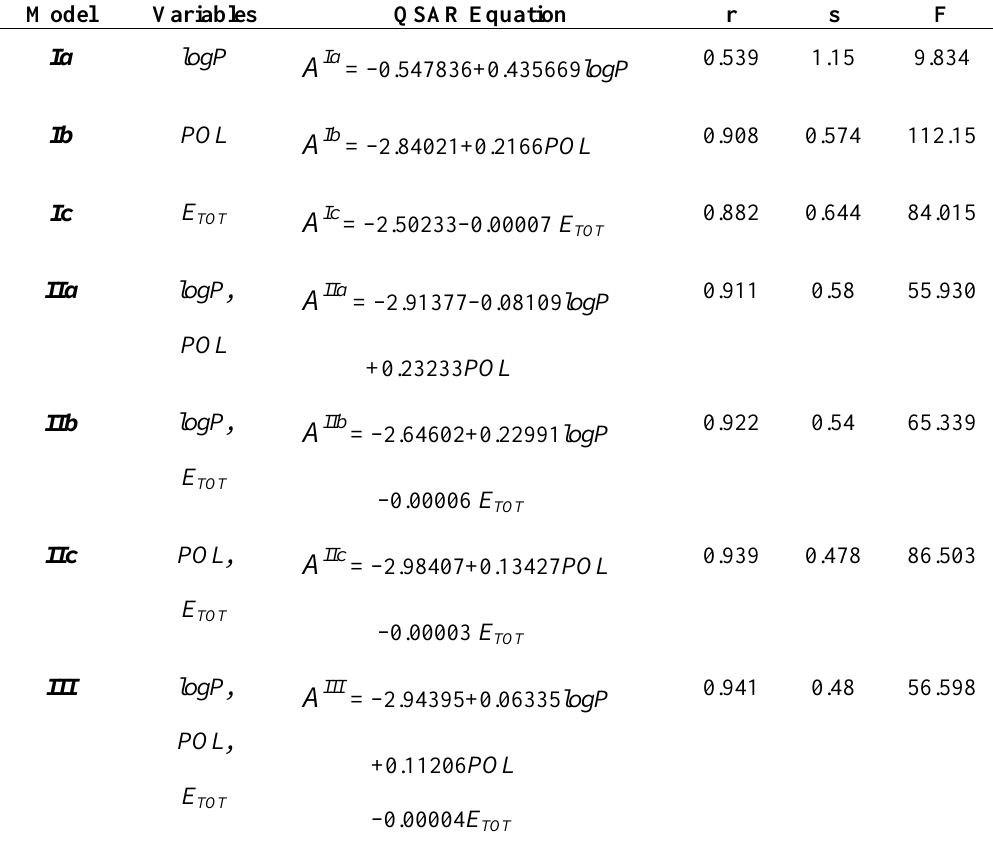
Table 4. QSAR equations through standard multi-linear routine of Satistica package [92] for all possible correlation models considered from data of Table